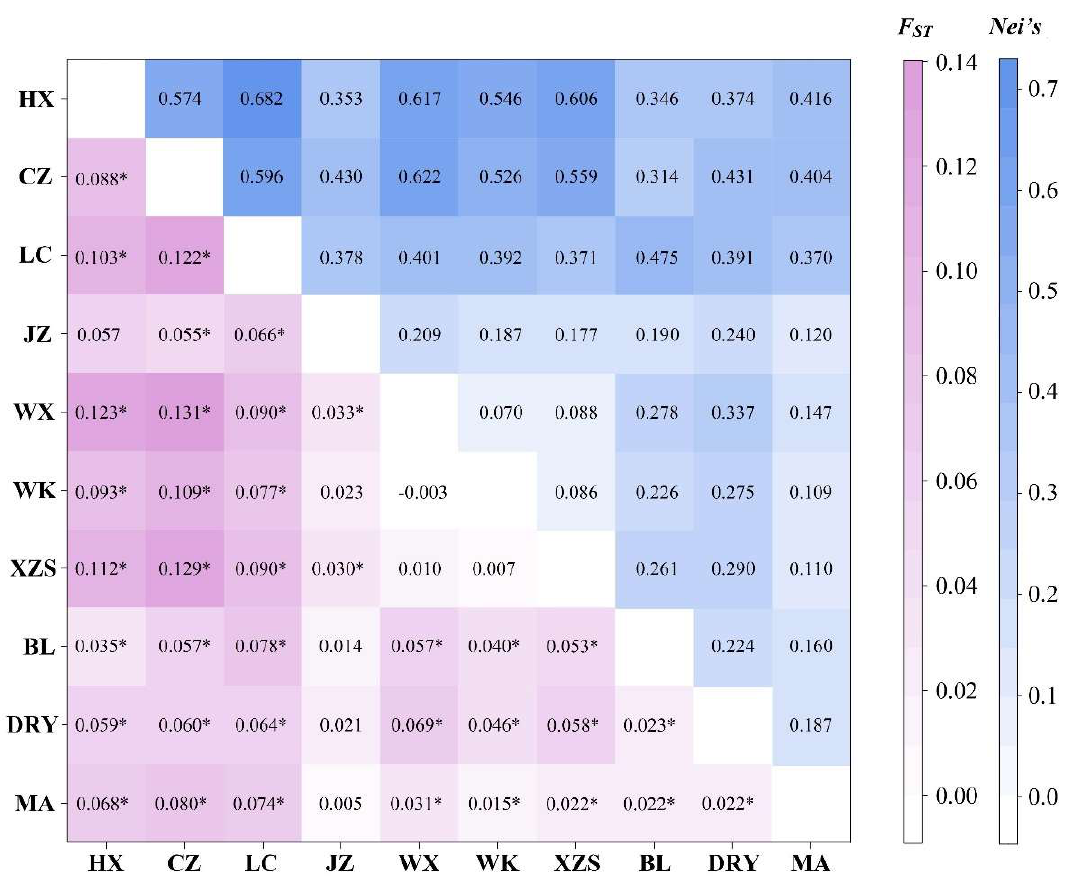
Figure 3. Pairwise differentiation estimates ( F ST ) (below the diagonal) and Nei ’s genetic distances (above the diagonal) of the 10 C. carpio populations based on 20 microsatellite loci. Values with * indicate statistical significance ( p < 0.001; p -value after adjusting for multiple comparisons = 0.05/45). Table 5. The AMOVA of carp cocultured in paddies in three counties based on 20 microsatellite loci.